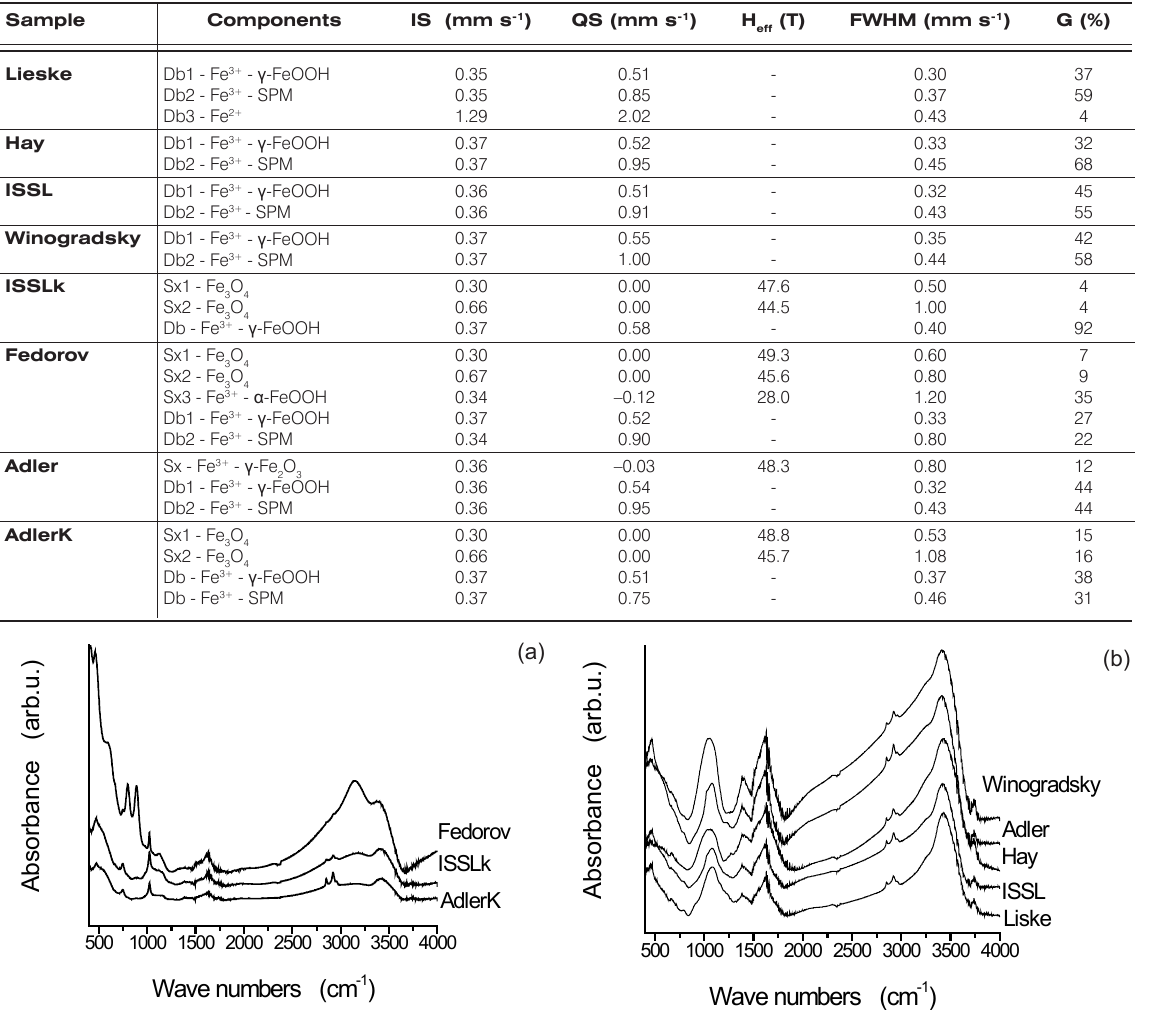
Table 4. Calculated values of Mossbauer parameters of biogenic materials cultivated in different feeding media. Sample